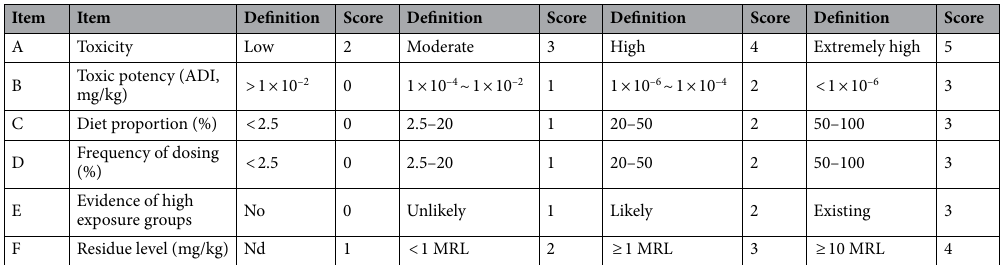
Table 3. Definition and score of A-F indices for risk scoring. Nd No evidence of detectable residues.